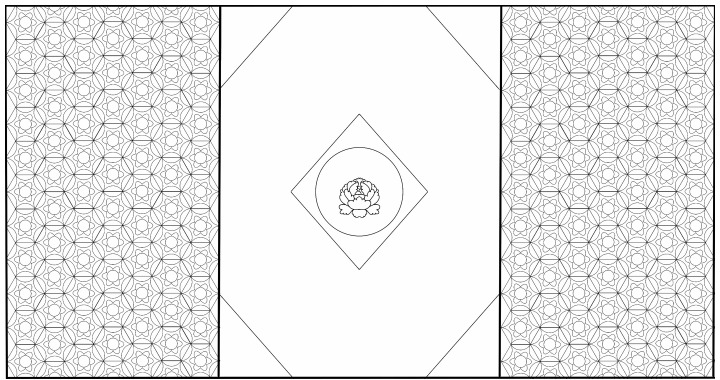
Figure 9. Composition of Brick Carving in Houzihe Qubbah of Qinghai province (by Guo Lanxi,